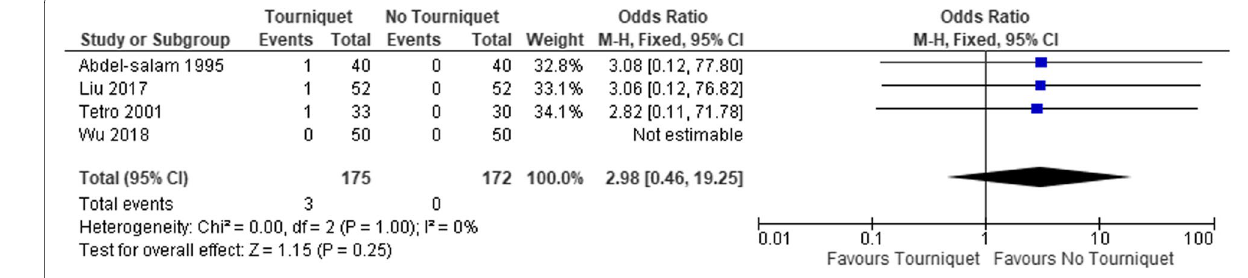
Fig. 7 Comparison of skin necrosis between the 2 groups